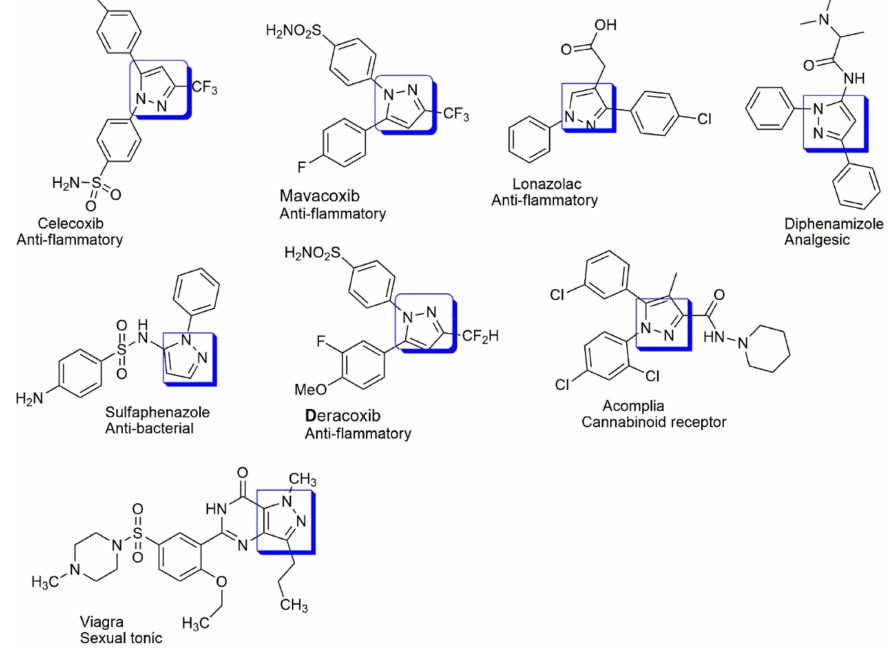
Figure 2. Some biologically active molecules containing pyrazole